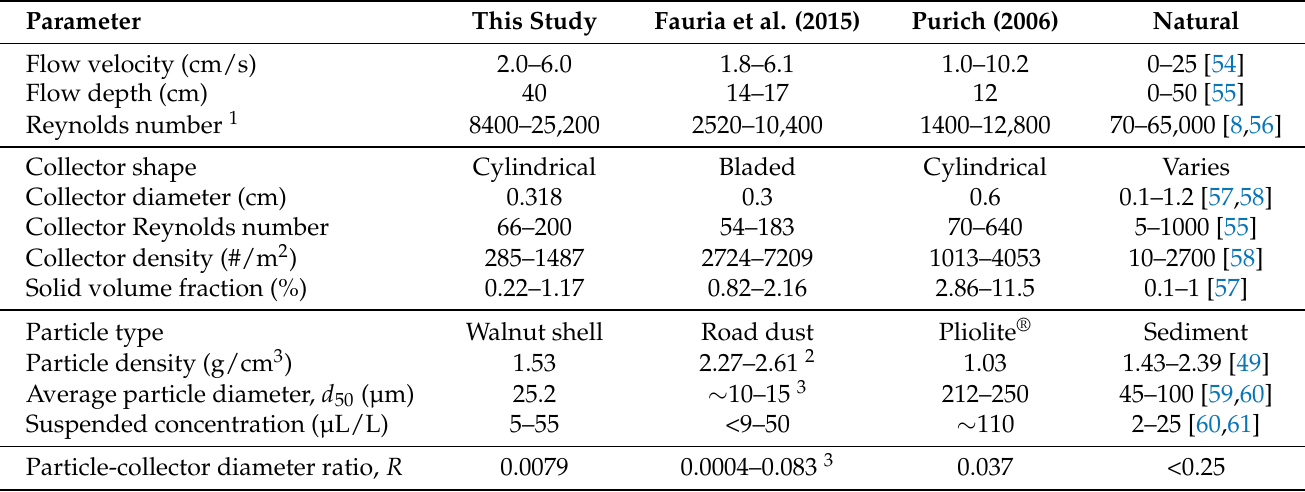
Table 1. Experimental and natural parameter ranges. Natural values are based on approximations or measurements from cited studies and literature reviews in wetlands or other low-gradient